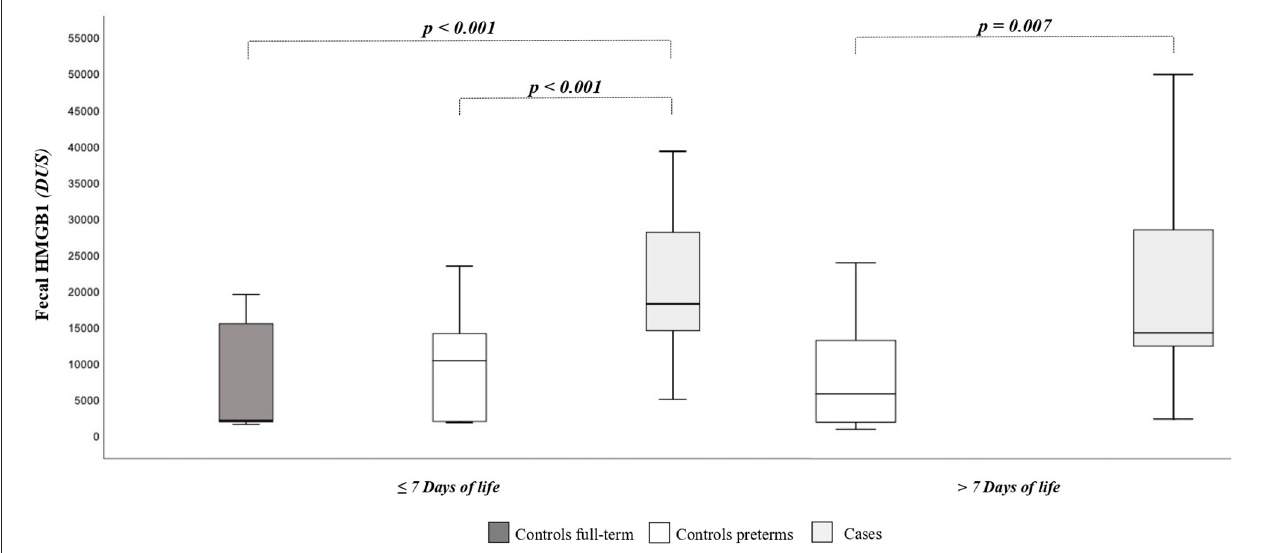
FIGURE 2 | High-mobility group box 1 fecal (HMGB1) levels according to days of postnatal life. The spacing between different parts of the box indicates interquartile range. Horizontal bold black line indicates median. The whiskers above and below the box show the locations of the minimum and the maximum. HMGB1, high-mobility group box 1; DUS, densitometry units; NEC, necrotizing enterocolitis.